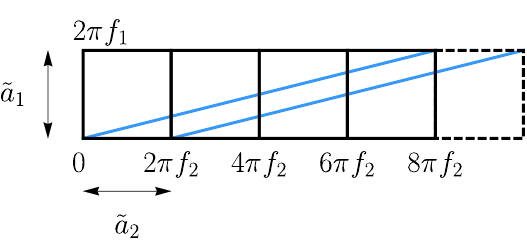
Figure 1. A gauge orbit for the U(1) local gauge symmetry for ( q 1 ; q 2 ) = (1 ; 4) (blue lines). The orbit corresponds to the direction of the would-be Goldstone boson. The direction perpendicular to the blue lines corresponds to the gauge-invariant Goldstone boson. The domain of the gauge-invariant Goldstone boson is given by the interval between the blue